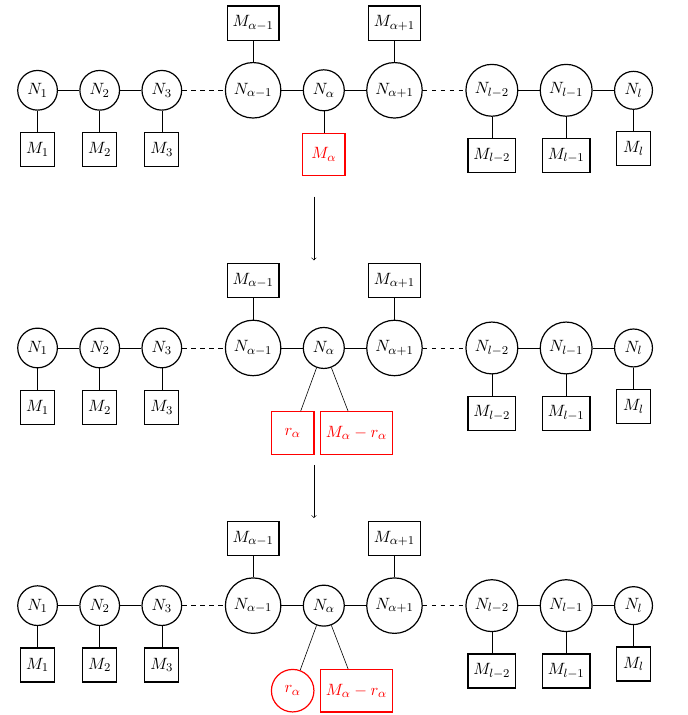
on a generic linear quiver X at a flavor P